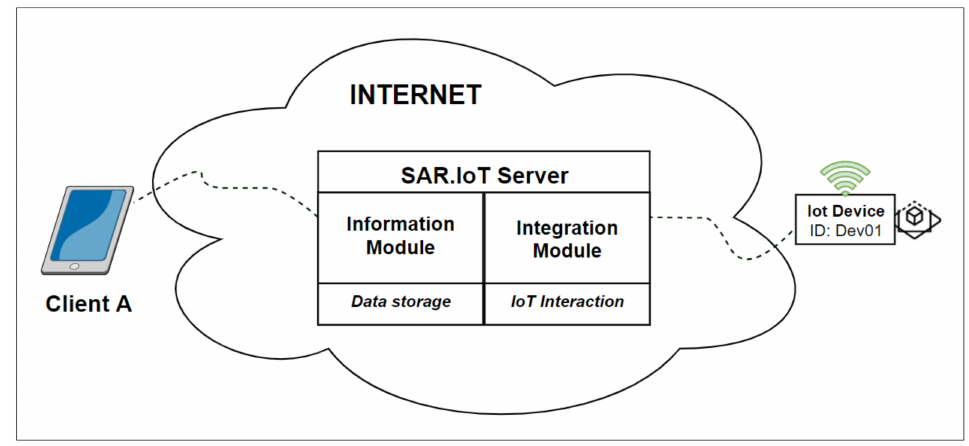
Figure 4. Server